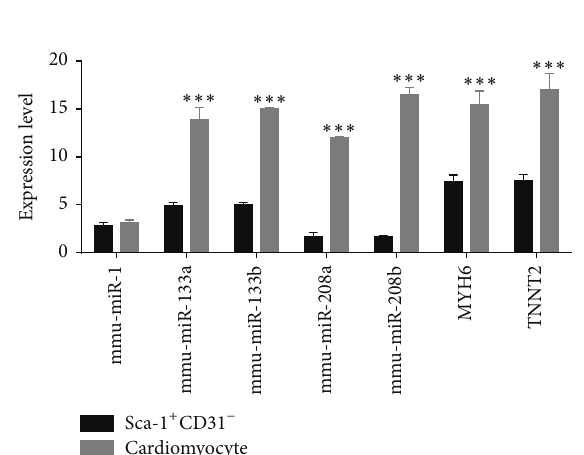
Figure 6: Expression of cardiomyocyte-specific miRNAs and mRNAs by dd-PCR. Bars: expression of genes in freshly isolated Sca-1 + CD31 − cells (black) or differentiated cardiomyocytes (gray). Expression was normalized to miRNA U6 and GAPDH and expres- sion was calculated based on a mean of three biological replicates. Differences were analyzed with Student’s 𝑡 -test. ∗∗∗ 𝑃 < 0.001 .